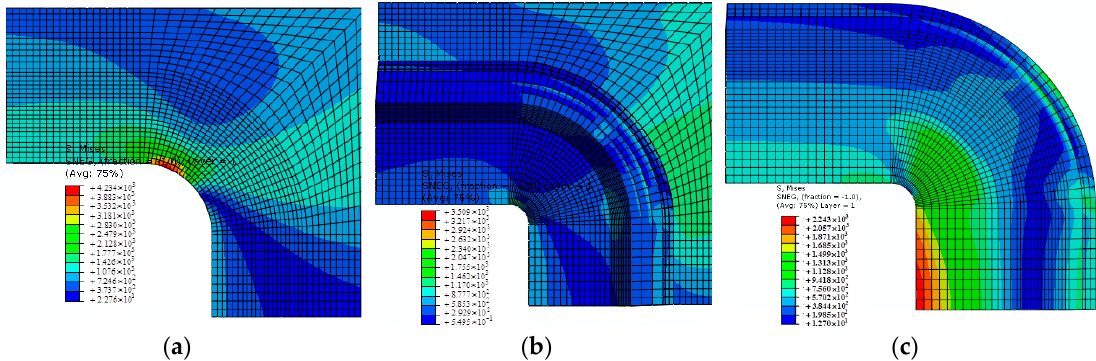
Figure 4. Von Mises stress distributions: ( a ) unreinforced; ( b ) reinforced, and ( c ) enlarged image of reinforced panel.